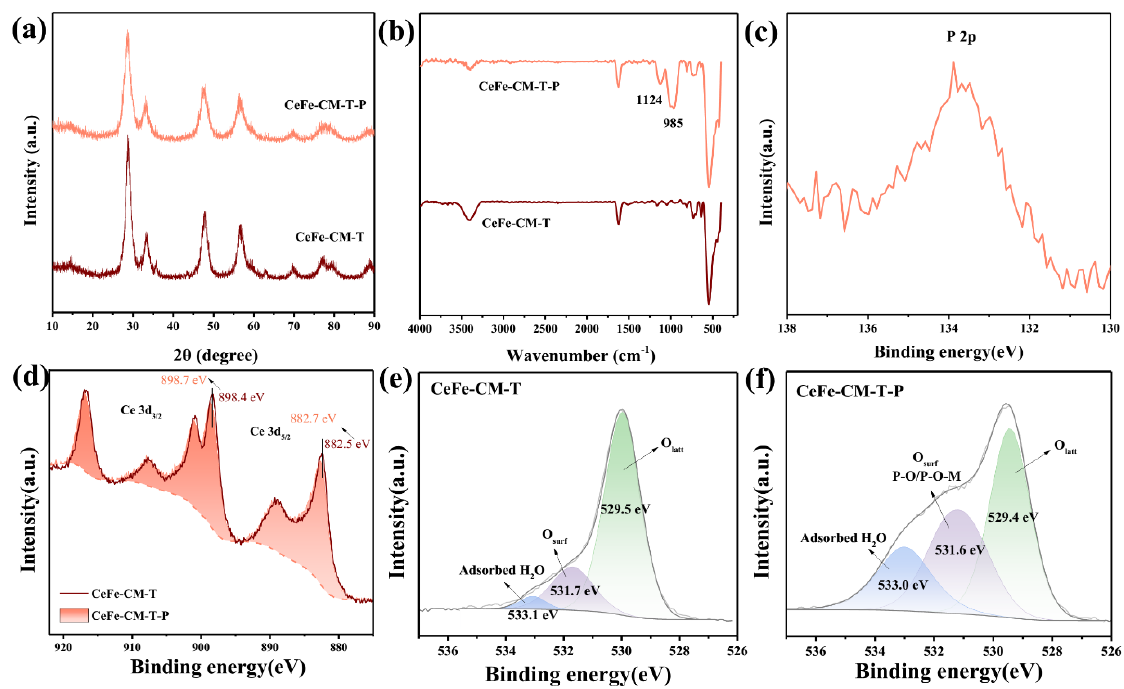
Figure 9. ( a ) XRD patterns and ( b ) FTIR spectra of CeFe-CM-T before and after phosphate adsorption; high-resolution XPS spectra of ( c ) P 2p of CeFe-CM-T-P, ( d ) Ce 3d, and ( e , f ) O1s before and after phosphate adsorption.